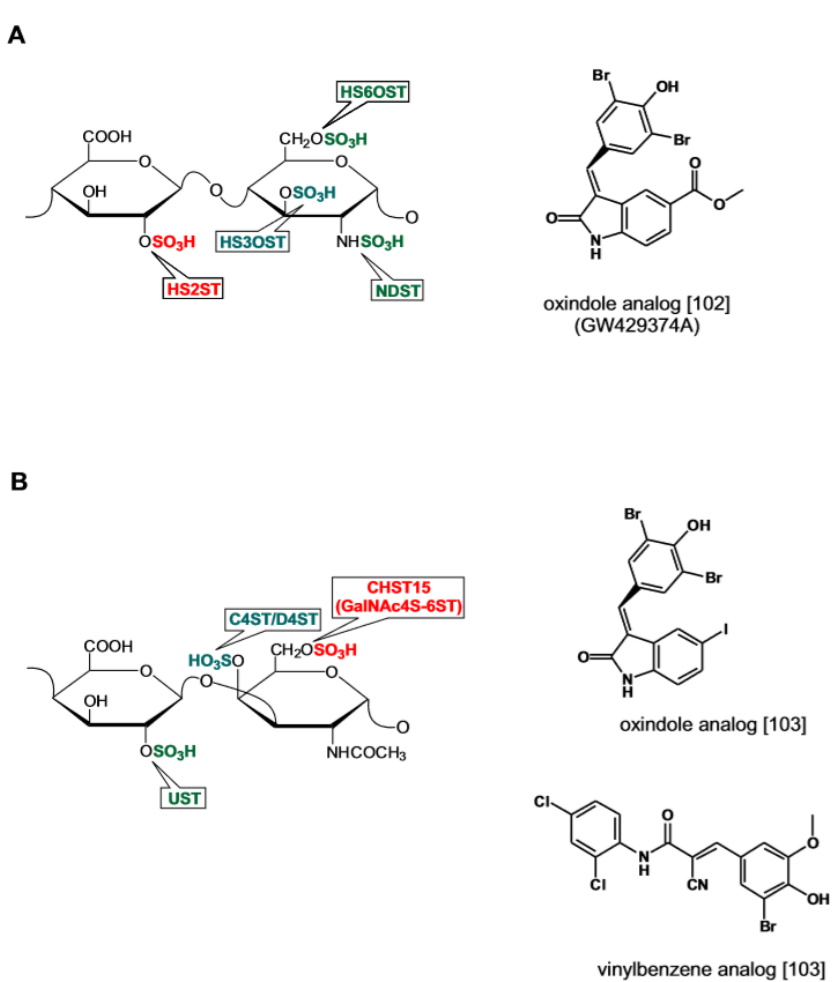
Figure 6. Catalytic activity of sulfotransferases acting on HS and CS and recently identified sulfotransferase inhibitors from screening of tyrosine kinase inhibitors (TKI) and diversity chemical libraries. ( A ) Oxindole HS2ST inhibitor. ( B ) Oxindole and vinylbenzene CHST15 inhibitors. Structures redrawn from refs [102,103].